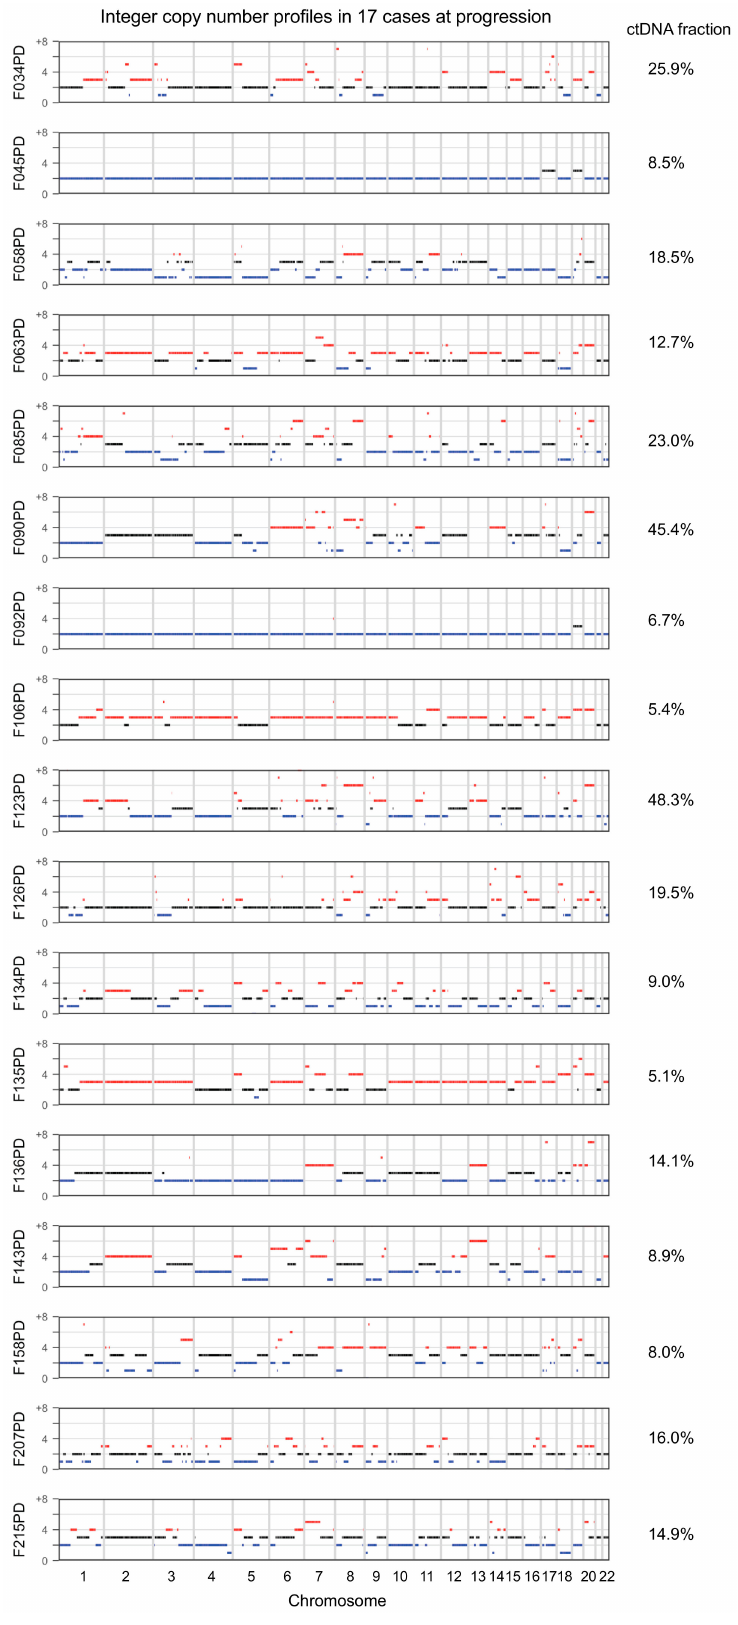
Figure A1. Integer copy number profiles for the 17 paired non-zero ctDNA cases at progression. ichorCNA ctDNA fraction is indicated for each